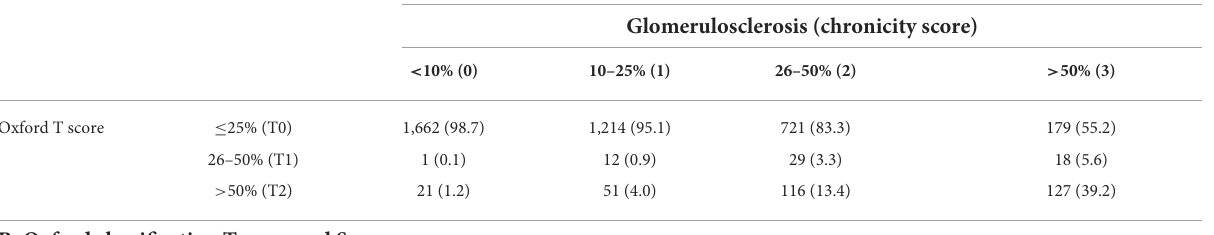
TABLE 4 Relationship between Oxford classification T score and glomerulosclerosis.